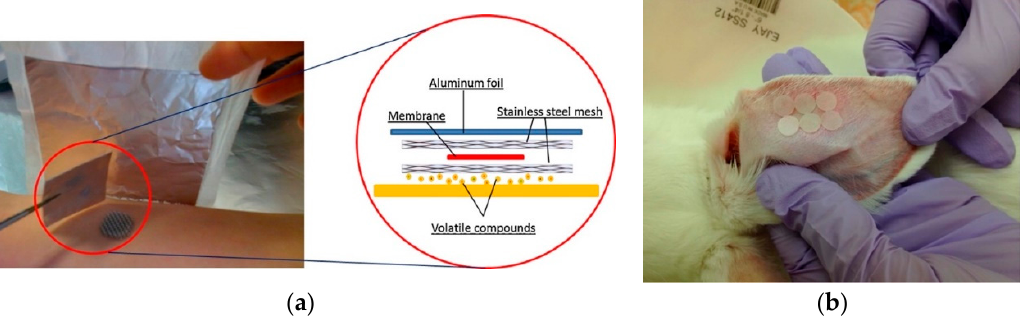
Figure 1. ( a ) Schematic diagram of the “membrane sandwich” headspace sampling for skin volatiles sampling. ( b ) Polydimethylsiloxane (PDMS) patches placed over the ventral ear surface for direct sampling. These were then covered with PTFE (polytetrafluoroethylene) and Tegaderm ® (not shown). Reproduced from [34,35], with permission from Elsevier and IOP Publishing, 2019.